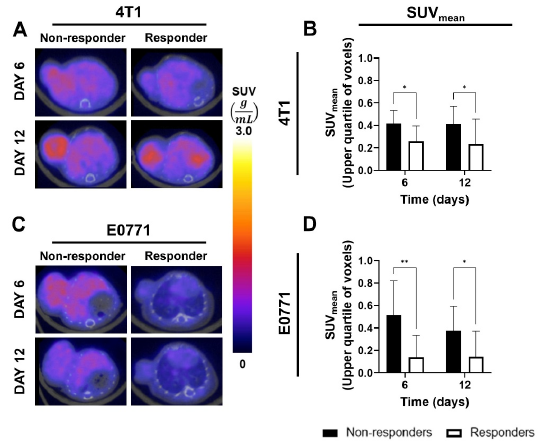
Figure 6. FMISO-PET imaging of hypoxia accurately predicts response to IMT and chemotherapy in TNBC tumors. Representative FMISO-PET images are shown of a nonresponder and responder (as measured by end tumor volume) within the combination IMT/PTX-treated mice and SUV mean of the upper quartile of voxels from ( A ) 4T1 and ( C ) E0771 tumors. SUV mean of the upper quartile of voxels from ( B ) 4T1 and ( D ) E0771 tumors reveal reduced hypoxia in tumors that respond better to treatment prior to changes in tumor size, seen on days 18 (4T1) and 15 (E0771). Mean ± SD (* indicates p < 0.05, ** indicates p < 0.01; multiple t -tests).